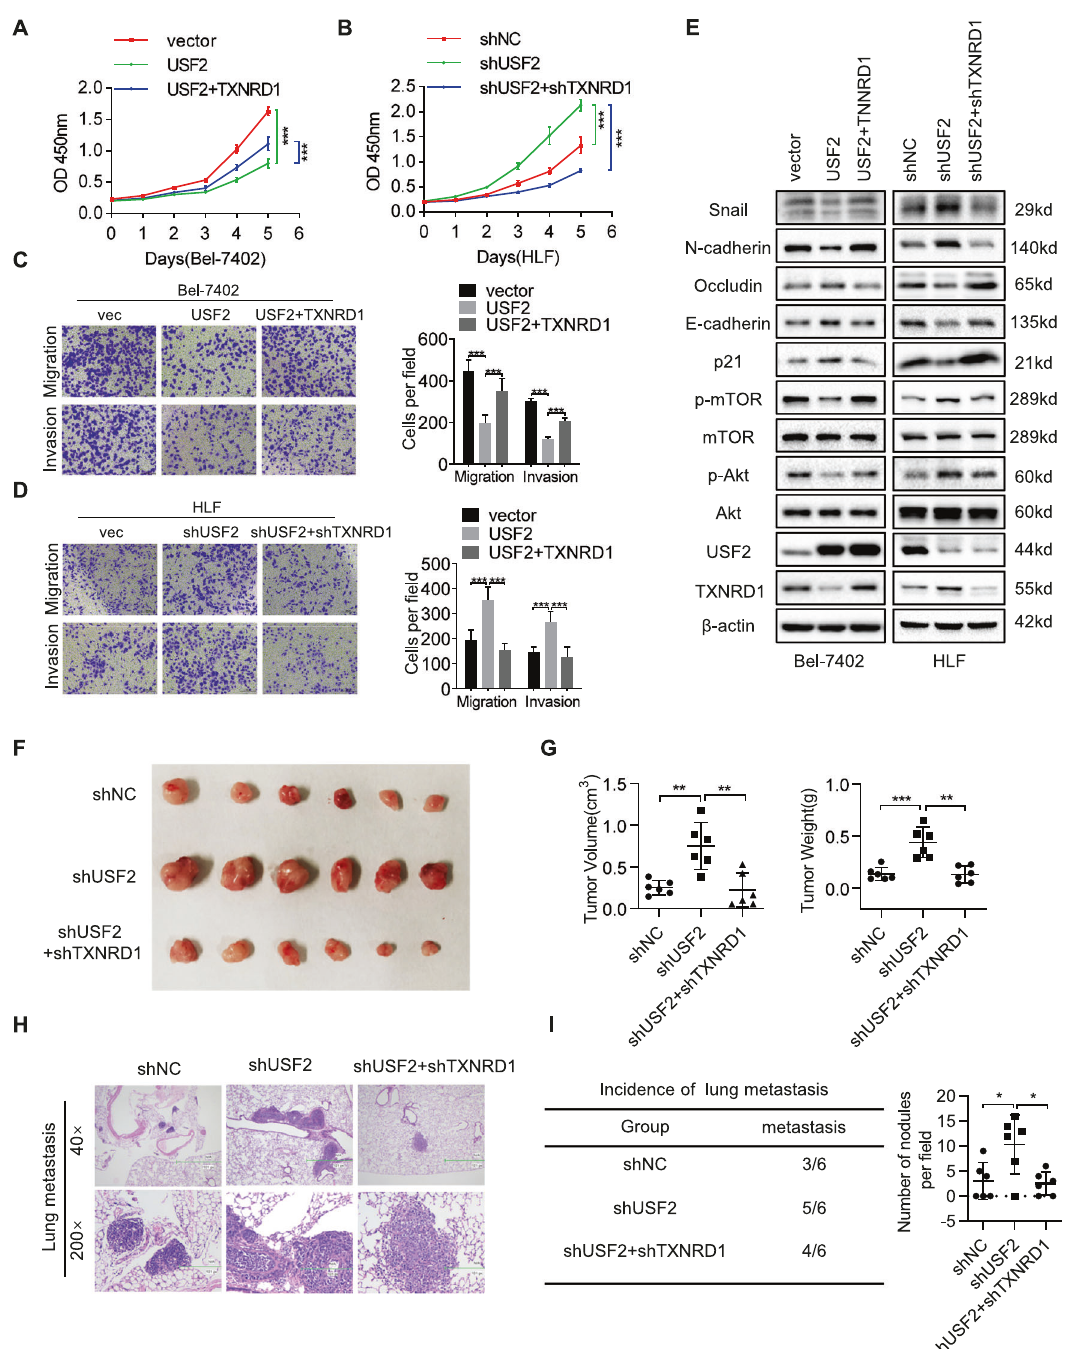
Fig. 6 USF2 suppresses the proliferation and metastasis of HCC cells by modulating the TXNRD1. A Bel-7402 cells were transiently transfected with USF2 or TXNRD1, cell proliferation abilities were measured by cell growth curve and CCK-8 assay. B HLF cells with USF2 knockdown were stably transfected shRNA targeting TXNRD1. Proliferation abilities of indicated cells were measured by cell growth curve and CCK-8 assay. C – D Cells migration and invasion abilities of indicated cells in ( A and B ) were determined by transwell assay. Representative images were shown in left, and the quantitative analysis was shown in right. E Cell lysates were prepared and subjected to western blotting for Snail, N-cadherin, E-cadherin, Occludin, p21, p-mTOR, mTOR, p-Akt, Akt, USF2, TXNRD1. β -actin was used as a loading control. F Subcutaneous tumors derived from shNC, shUSF2 or shUSF2 + TXNRD1 HLF cells were photographed. G Average weight and volume of excised tumors were determined. H Lung metastasis in nude mice inoculated with shNC, shUSF2 or shUSF2 + TXNRD1 HLF cells via tail vein for 8 weeks was constructed. Representative HE stained lung tissue sections was presented. I Statistical analysis of the incidence of lung metastases is shown (left). The number of visible metastatic nodules in each group is counted in dot chat (right). Data represent the mean ± SD or mean ± SEM. * P < 0.05, ** P < 0.01, *** P < 0.001. P values were calculated by One-way